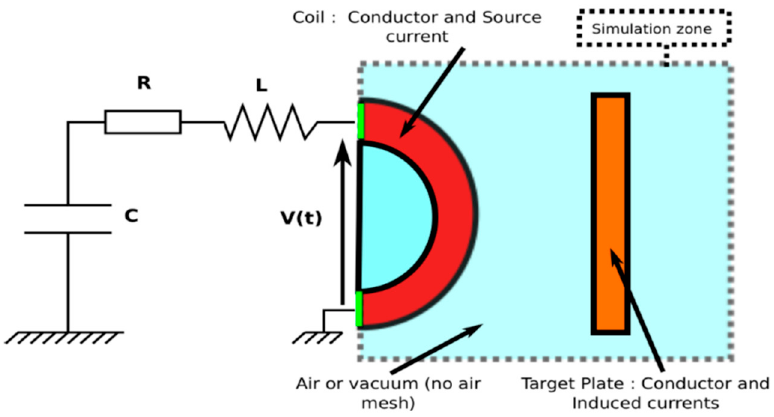
Figure 10. Problem with (R, L, C) imposed voltage on the coil [28]